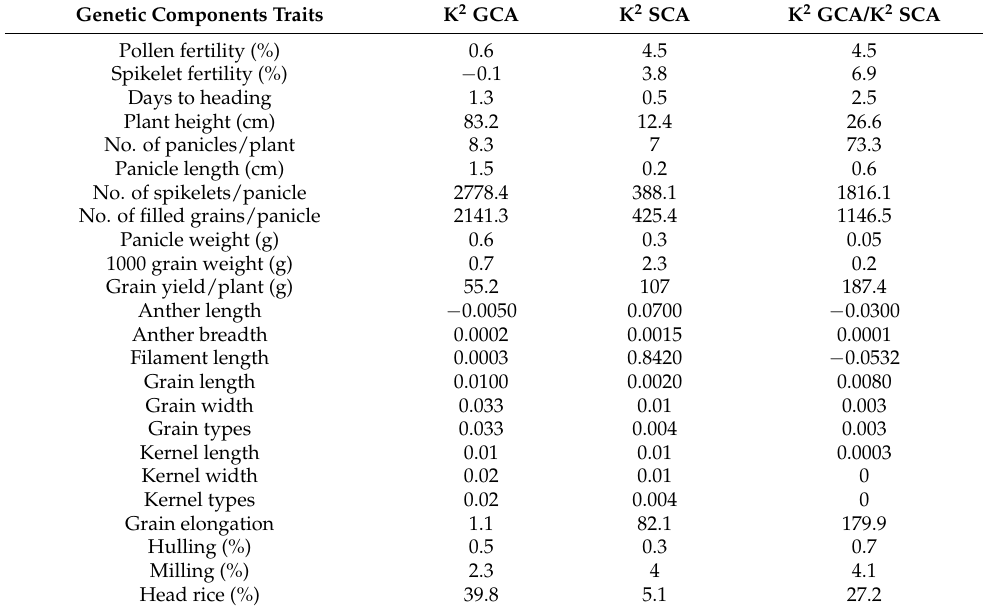
Table 3. The ratio between K 2 GCA and K 2 SCA for the grain yield, yield contributing traits, floral traits, and grain quality traits the studied genotypes.